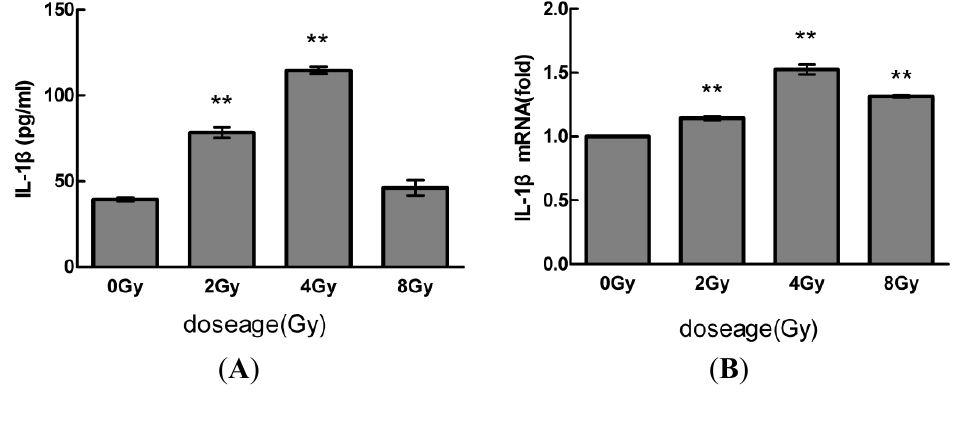
Figure 1. Radiation elevates IL-1 β levels in MSCs after radiation. ( A ) Dose-dependent increase in IL-1 β secretion and ( B , C ) dose-dependent increases in IL-1 β mRNA and protein expression. Cells were exposed to various doses of radiation (0, 2, 4, and 8 Gy), and after 24 h, extracellular and intracellular protein and mRNA levels of IL-1 β were determined by ELISA, Western blot, and quantitative real-time PCR analyses,